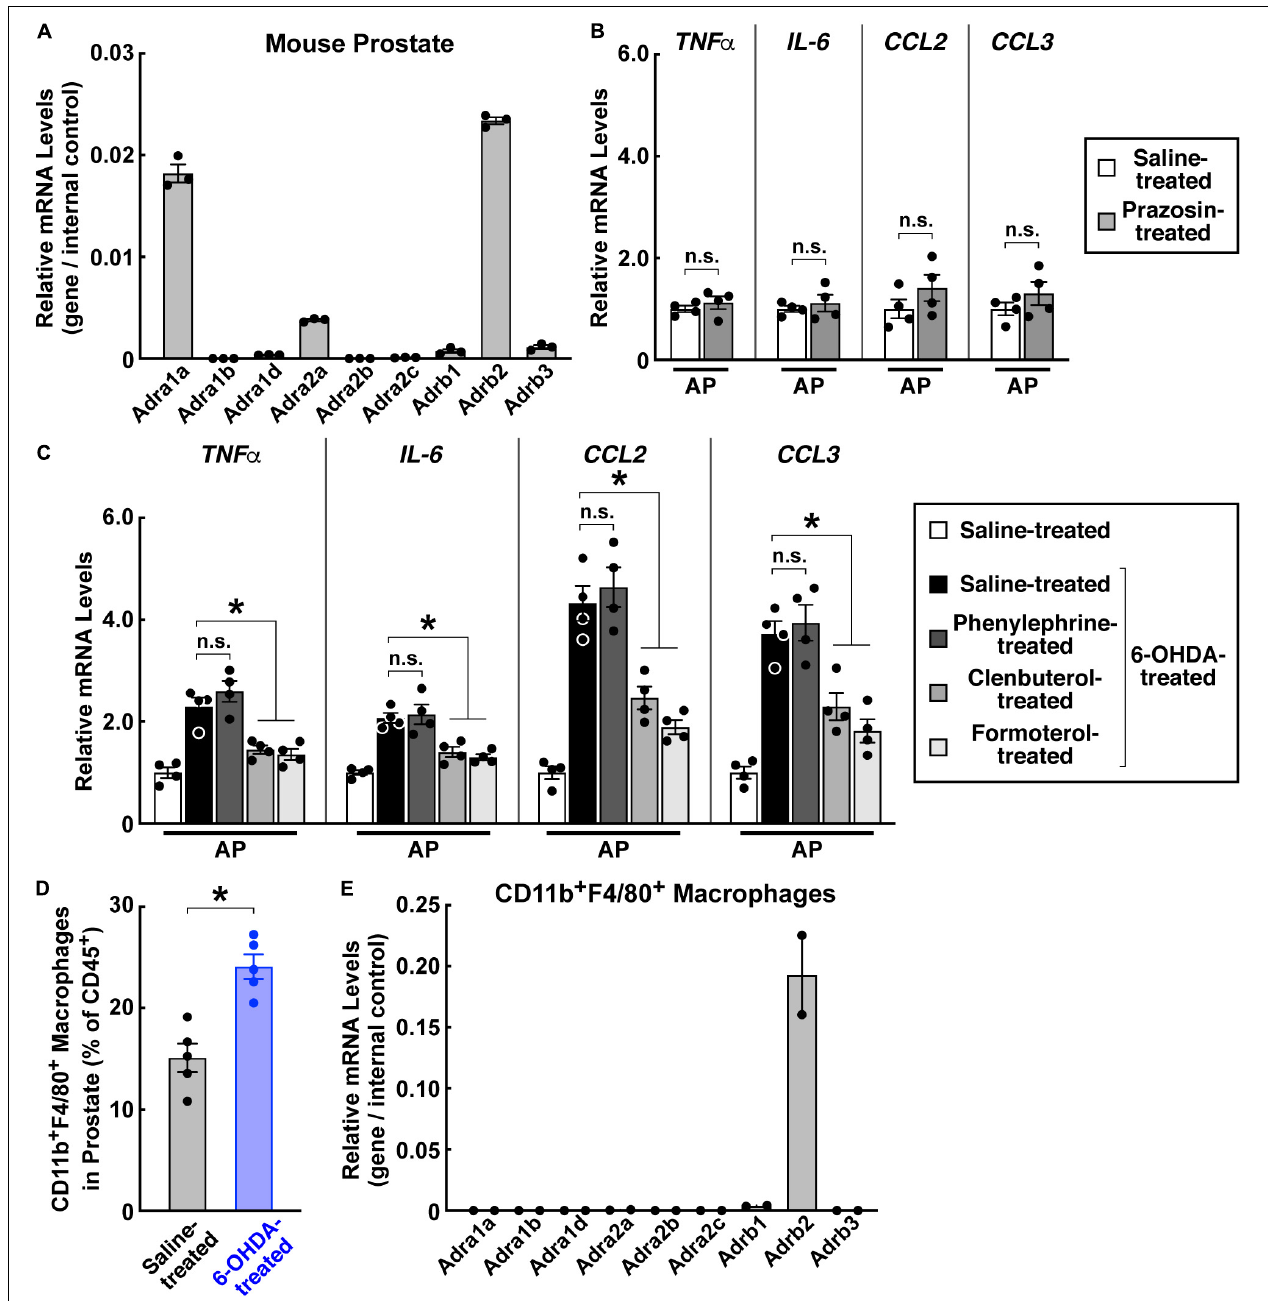
FIGURE 6 | β 2-Adrenergic receptor signal suppressed the prostate inflammation caused by sympathetic loss. (A) Expression profile of adrenergic receptors in the mouse prostate. mRNA levels of adrenergic receptors in the prostates of 8-week-old male mice were analyzed by the qPCR analysis. n = 3, mean ± SEM. (B) The α 1-adrenergic receptor antagonist did not cause prostate inflammation. Eight-week-old male mice were daily administered with prazosin via intraperitoneal injection for 14 days. mRNA levels of pro-inflammatory cytokines and chemokines in the anterior prostate (AP) were analyzed by the qPCR analysis. n = 4, mean ± SEM, n.s., not significant (Student’s t -test). (C,D) 8-week-old male mice were intraperitoneally treated with 6-hydroxydopamine or saline control. (C) The β 2-adrenergic receptor agonists suppressed prostate inflammation caused by sympathetic loss. The mice at 2 weeks after the 6-OHDA treatment were daily administered with the α 1-adrenergic receptor agonist phenylephrine or β 2-adrenergic receptor agonists clenbuterol or formoterol via intraperitoneal injection for 5 days. mRNA levels of pro-inflammatory cytokines and chemokines in the anterior prostate (AP) were analyzed by the qPCR analysis. n = 4, mean ± SEM, * p < 0.05, n.s., not significant (one-way ANOVA test). (D) Increased accumulation of CD11b + F4/80 + macrophages during prostate inflammation. Immune cells in the anterior prostate at 2 weeks after the 6-OHDA treatment were examined by the FACS analysis. n = 5, mean ± SEM, * p < 0.05 (Student’s t -test). (E) Expression profile of adrenergic receptors in CD11b + F4/80 + macrophages of the prostate. mRNA levels of adrenergic receptors in the CD11b + F4/80 + macrophages FACS-sorted from the prostate were analyzed by the qPCR analysis. n = 2, mean.